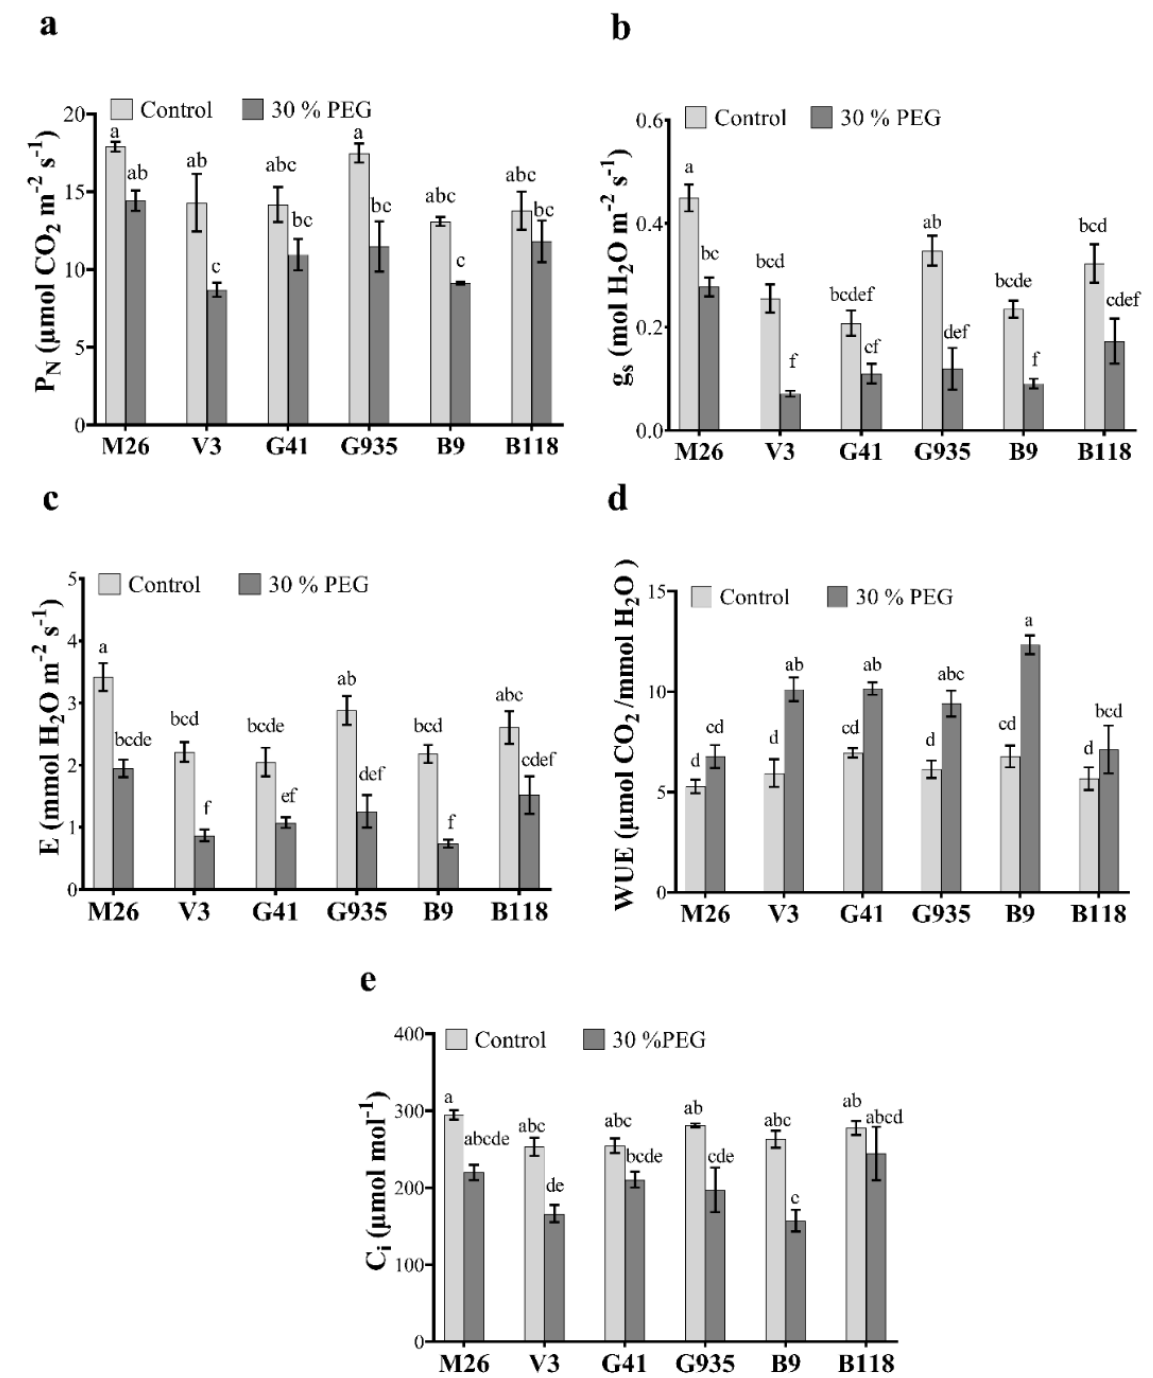
Figure 2. Changes in photosynthesis-related parameters in six apple rootstocks under osmotic stress conditions. Photo- synthesis rate (P N ) ( a ), stomatal conductance (g s ) ( b ), transpiration rate (E) ( c ), WUE (P N /E) ( d ) and intercellular CO 2 concentration (C i ) ( e ) observed in control and osmotic-stressed apple rootstocks (M26, V3, G41, G935, B9 and B118) three days after treatment with 30% PEG Means from all the treatments were compared with each other using Tukey’s test. Vertical bars represent the mean ± SEM of three biological replicates (three plants each). Bars with no common letters are significantly different ( p <